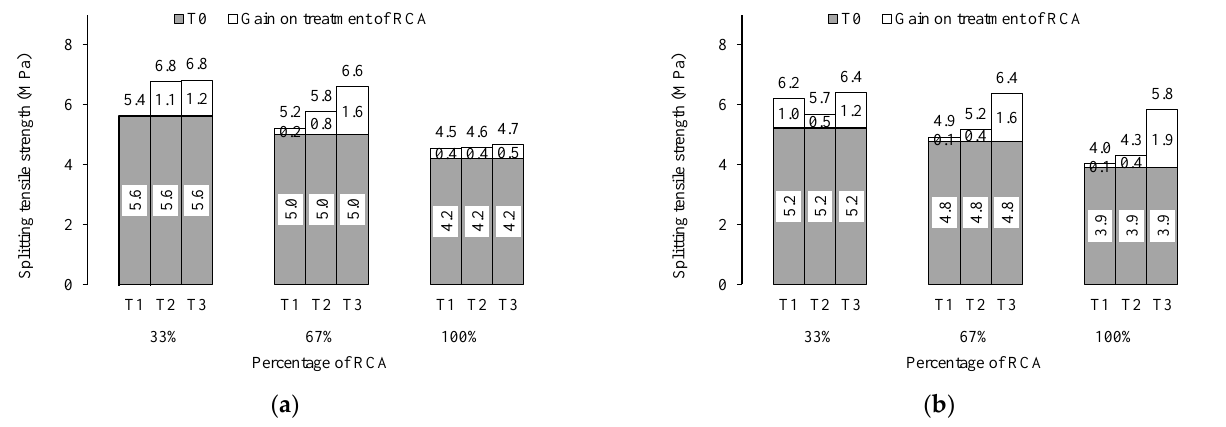
Figure 12. Splitting tensile strength results of untreated and treated RCA for: ( a ) 10-mm aggregate; and ( b ) 20-mm aggregate.